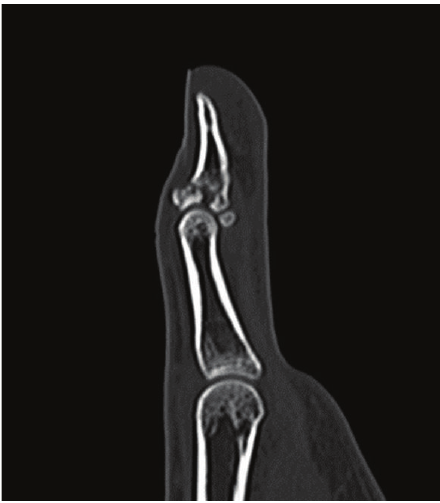
Figure 3: The fracture was repaired by the two extension block Kirschner wires’ technique.